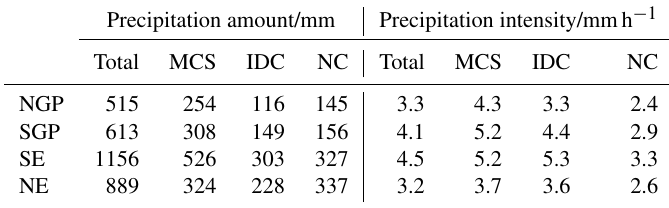
Table A3. Annual mean precipitation amounts and intensities for different types of precipitation in different regions of the US for